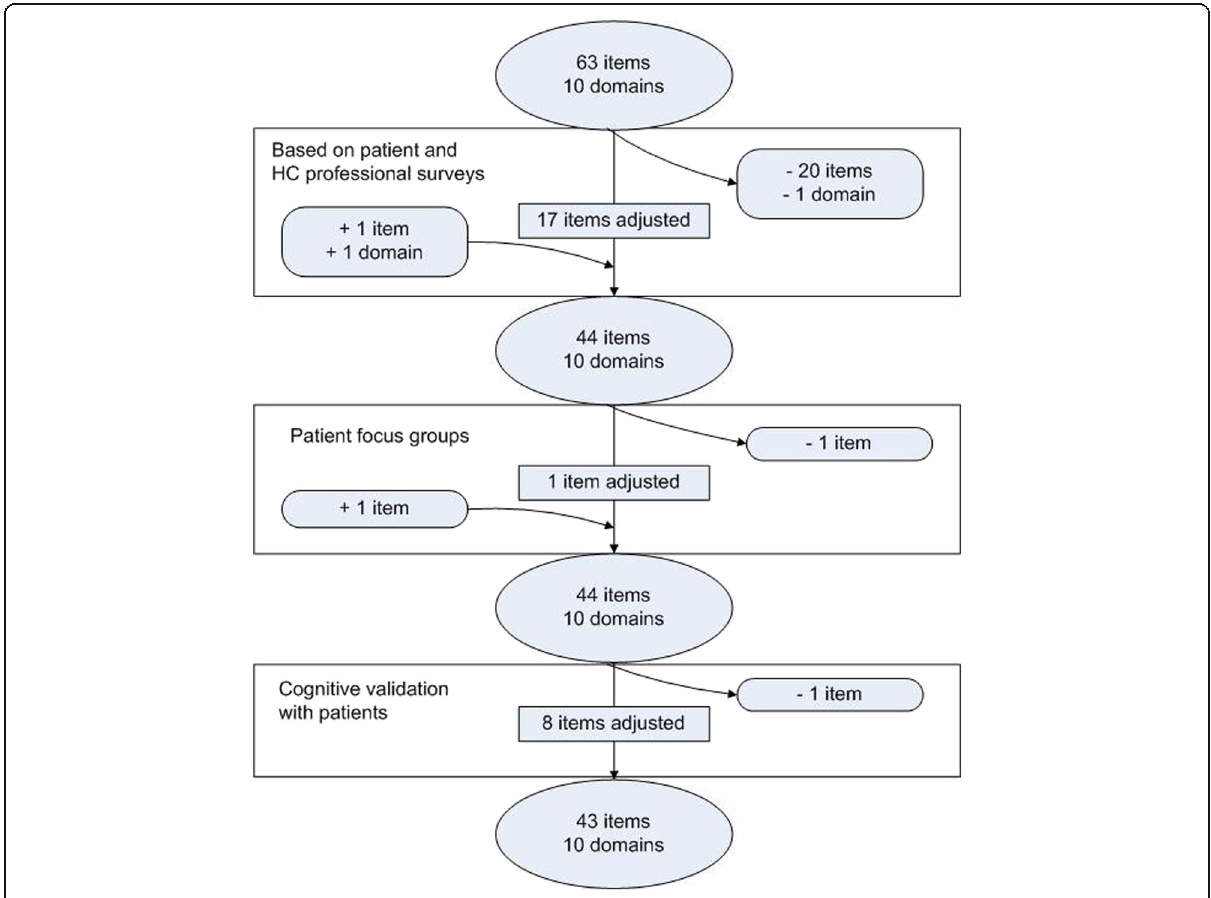
Fig. 1 Flow chart of the PRAQ development